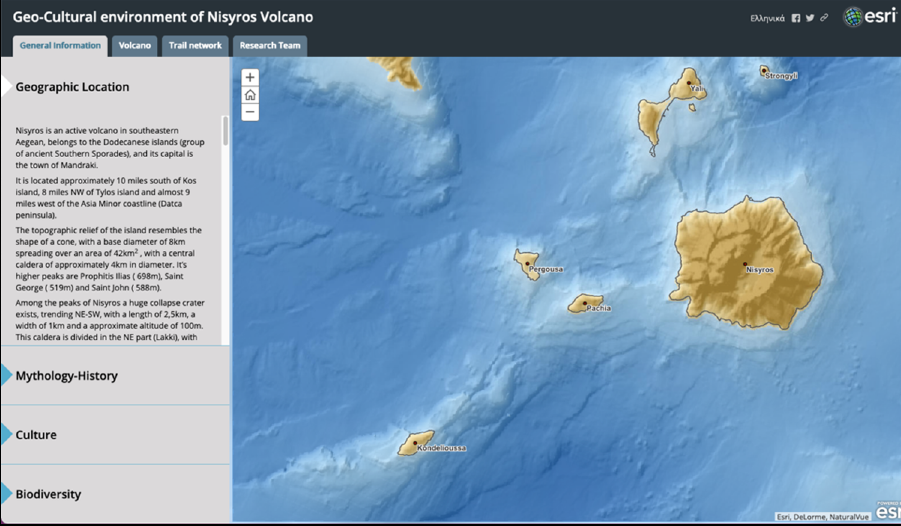
Figure 6. Screenshot showing the main part of the app that appears once a language is selected, featuring four main tabs-pages, each one of which includes additional information organized within vertical tabs. The first one, regarding general information, is active.